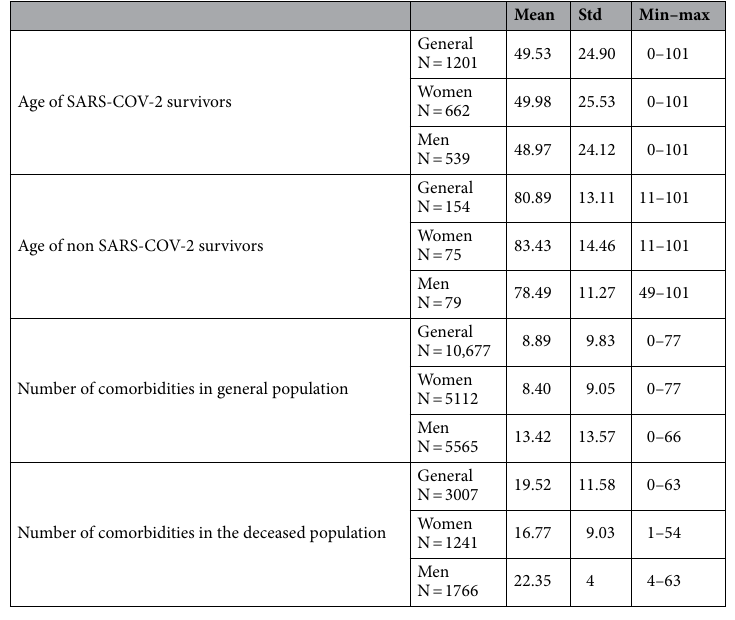
Table 2. Baseline characteristics and comorbidity of patients with coronavirus disease (SARS-COV-2).